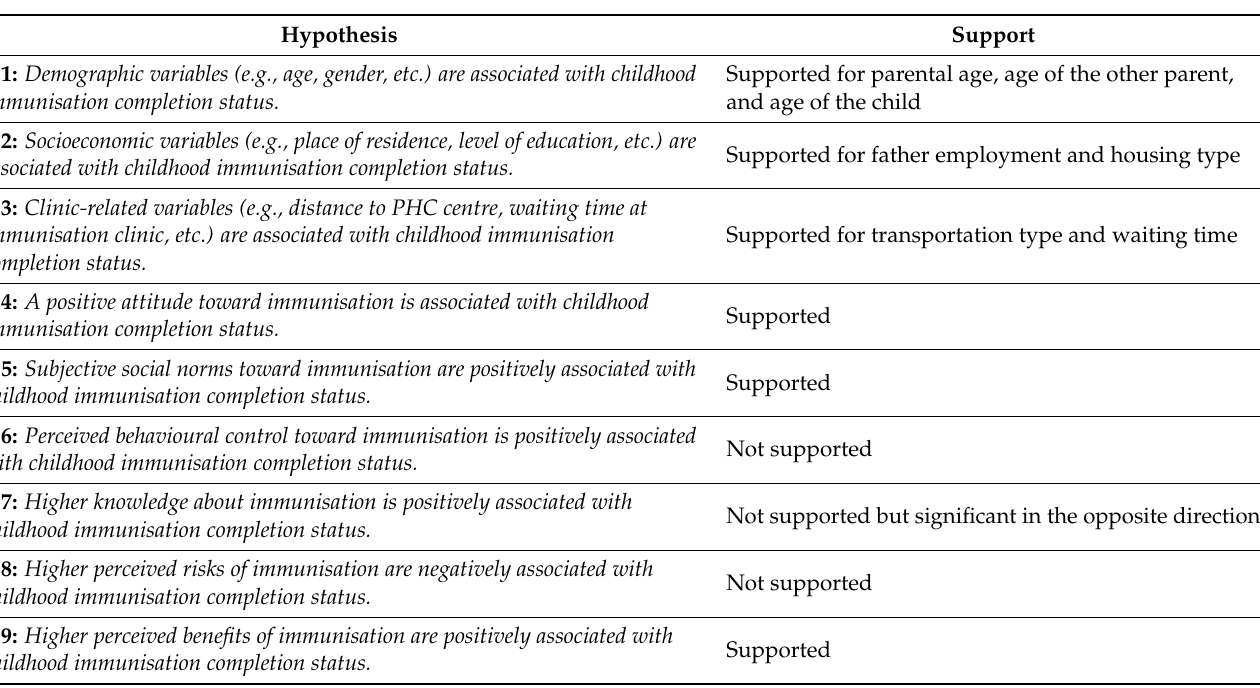
Table 7. Summary of hypothesis testing